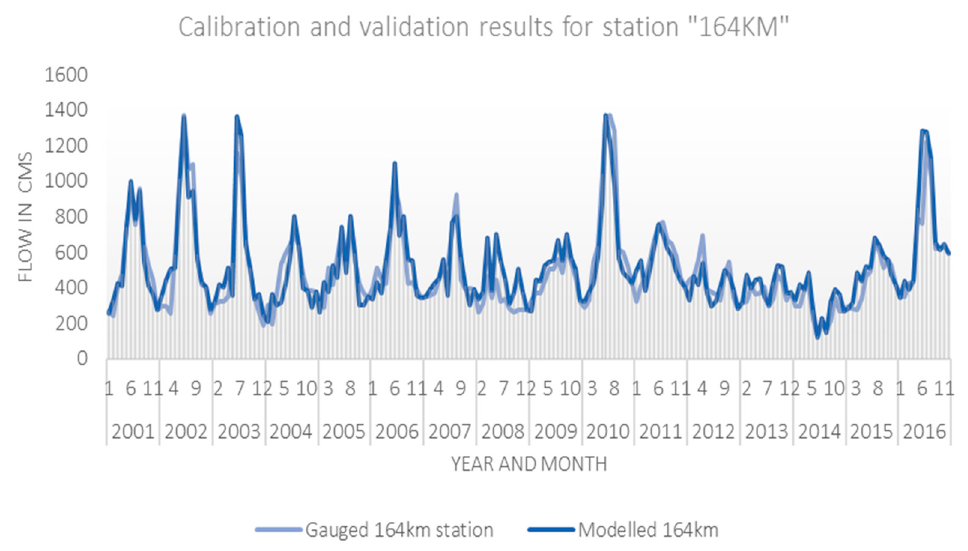
Figure A2. Calibration and validation results for gauge station “164 km above Figure A2 Calibration and validation results for gauge station “164 km above KapHES”.